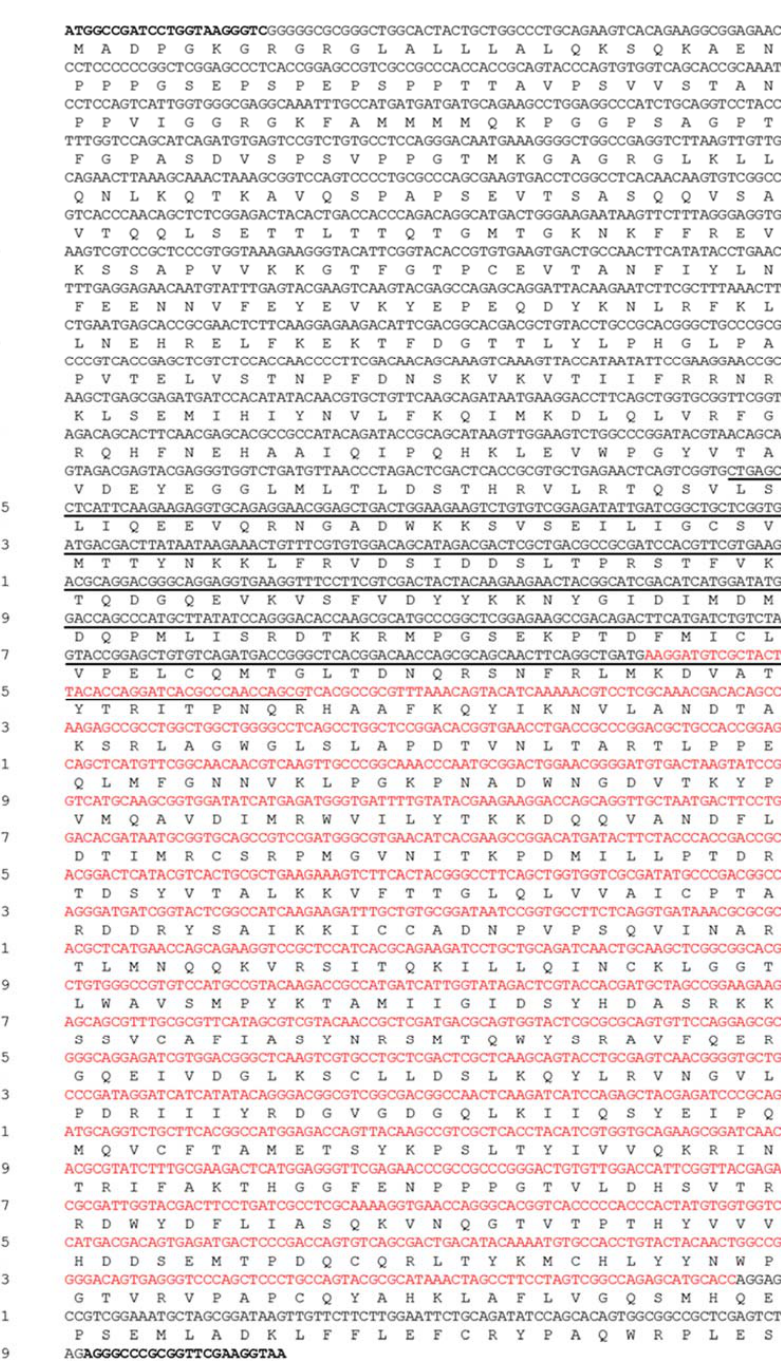
Figure 1. The complete coding sequence and the assumed amino acid sequence of PxAgo3 . The coding sequence is of 2832 bp, starting from ATG marked in boldface and ending with TAA denoted with asterisk (*). The protein sequence is of 943 aa under the nucleotide sequence, with two motifs of the PAZ domain (underline, position 337–477) and the PIWI domain (red in color, position 464–909). Besides this, PCR primers (sense and antisense) are highlighted in bold.